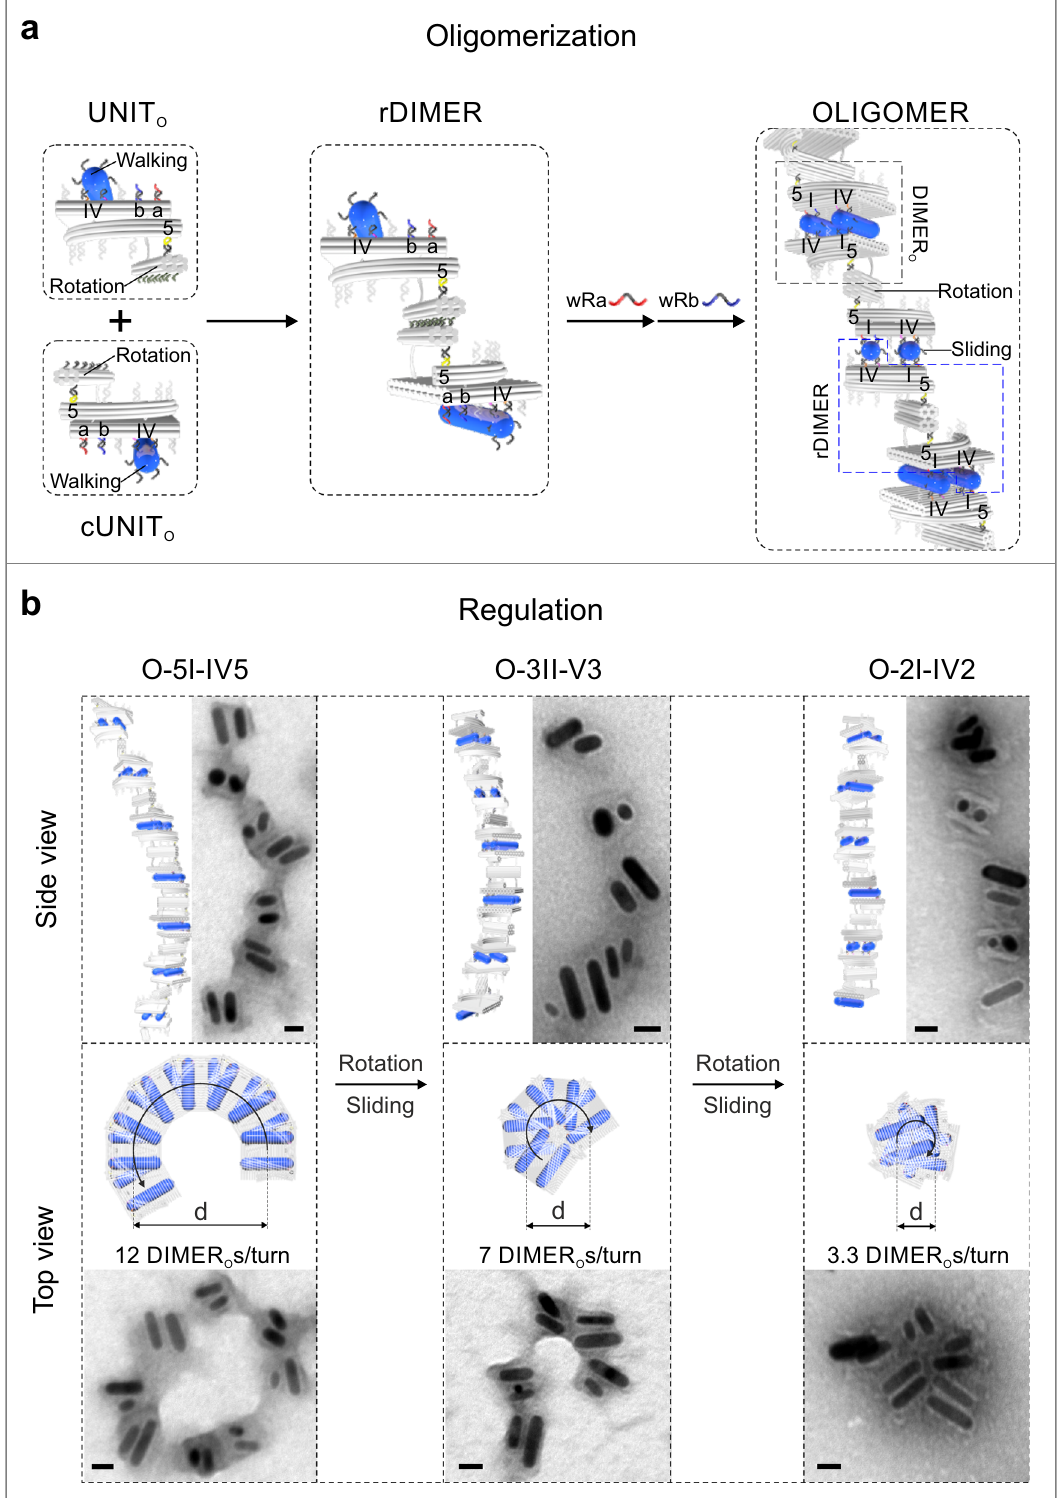
Fig. 5 Oligomerization of the UNITs for high-order structures. a Schematic of the oligomerization of the UNIT O s. The rotary bundles in UNIT O and cUNIT O are functionalized with complementary strands (10 olive strands in UNIT O and 10 dark gray strands in cUNIT O ). Both UNIT O and cUNIT O are at state IV5. The intermediate dimeric structure is called rDIMER. The fi nal OLIGOMER is at state O-5I-IV5, containing both helical queues of rDIMERs and DIMER O s. b Regulation of the OLIGOMERs. Schematics and TEM images of the side views and top views of the OLIGOMERs at different states. The OLIGOMERs recon fi gure from state O-5I-IV5 to O-3II-V3, and then to state O-2I-IV2 through simultaneous rotation and sliding